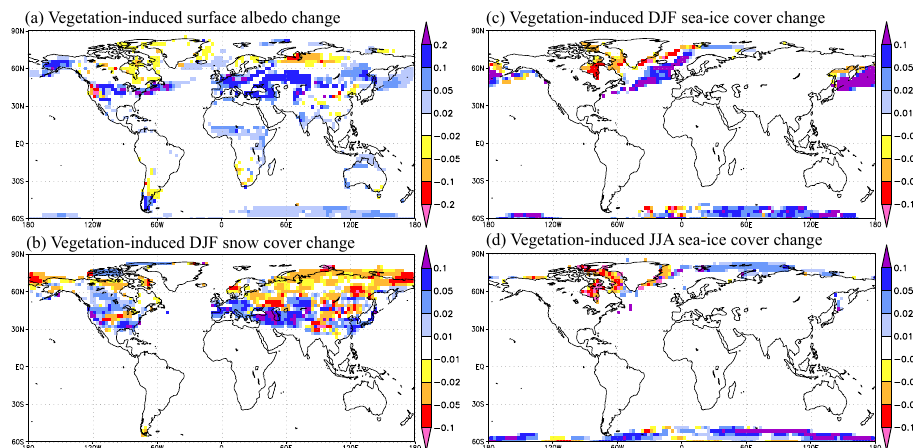
Fig. 5. (a) Annually averaged contribution of vegetation change (which was calculated as (AOV(LGM) − AOV(PI)) − (AO(LGM) − AO(PI)) Annually averaged contribution of vegetation change (which was calculated as to surface albedo, (b) same as (a) but December-January-February averaged snow cover fraction, (c) same as (a) but December-January- ( AOV(LGM) − AOV(PI) ) − ( AO(LGM) − AO(PI) ) to surface albedo, (b) as same as (a) but February averaged sea-ice cover fraction and (d) same as (a) June-July-August averaged sea-ice cover ratio. December-January-February averaged snow cover fraction, (c) as same as (a) but December- January-February averaged sea-ice cover fraction and (d) as same as (a) June-July-August averaged sea-ice cover ratio. to be virtually the same as the actual GCM